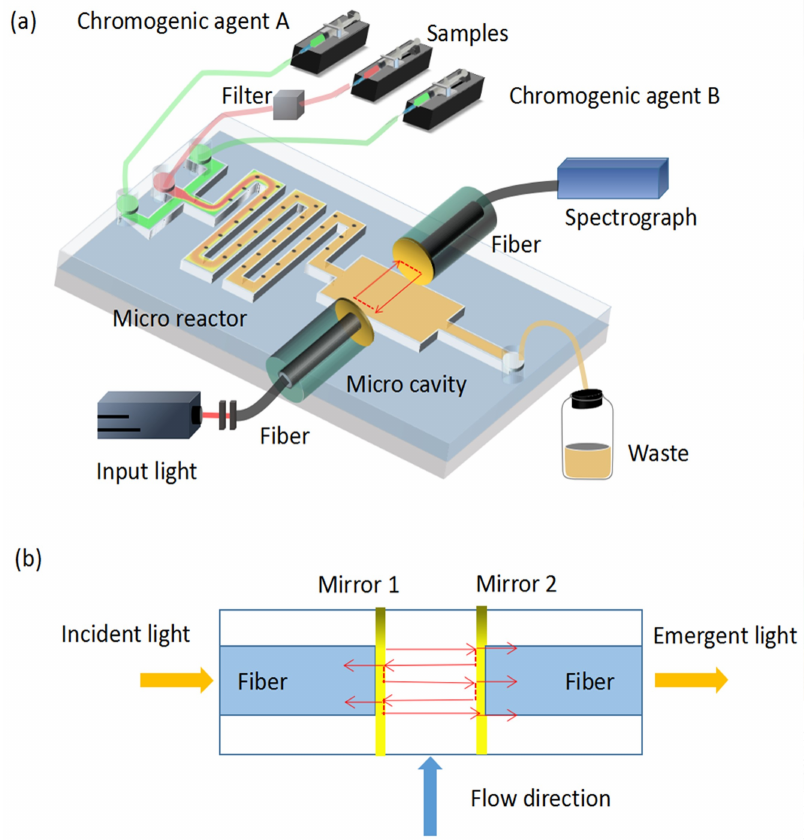
Figure 1. An optofluidic device based on the Fabry–P é rot resonator used to detect marine phosphate. ( a ) A 3D schematic of the setup. The microchannel area is 250 µ m of width; the F–P cavity is 300 µ m of length. ( b ) The microcavity is composed of two pairs of gold-coated optical fiber facets